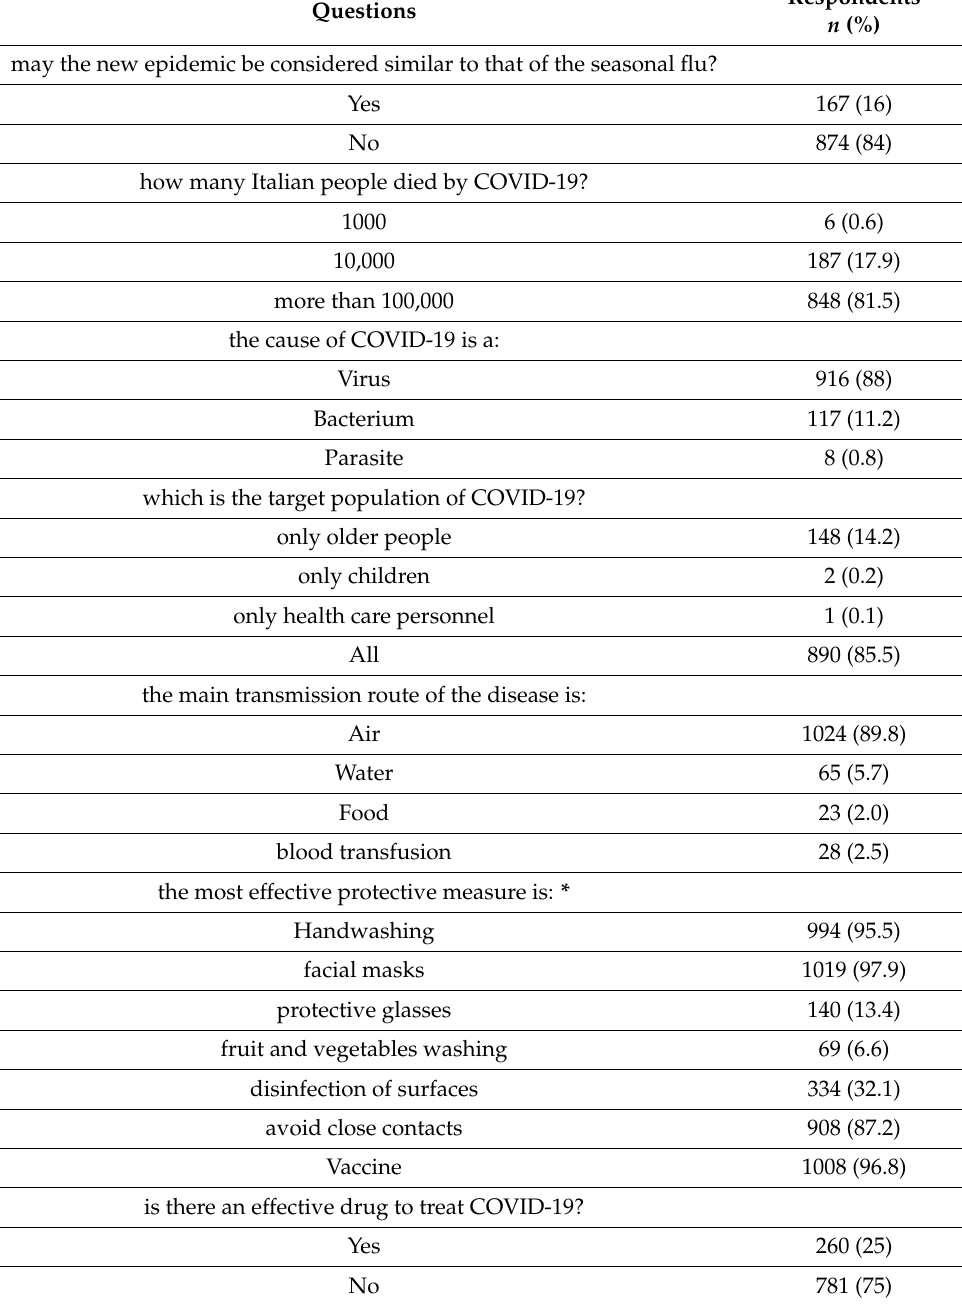
Table 2. Answers related to participants’ knowledge about